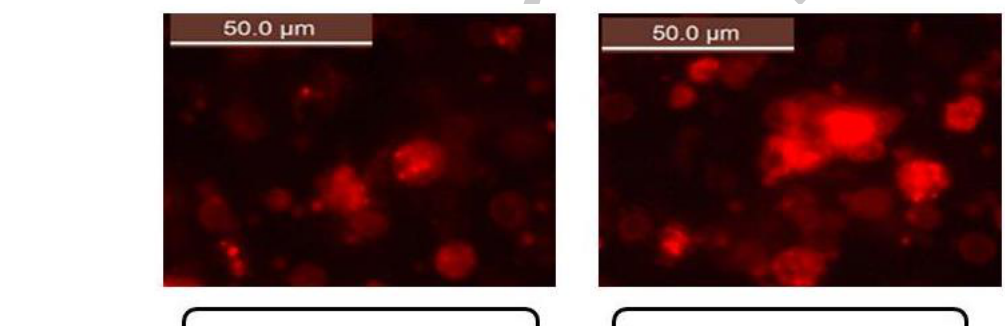
Figure 3. Stem cells labeled with PKH26 dye in pancreatic tissues of diabetic groups at the end of the experiment (50.0 µm) shown under a fluorescence microscope. MSCs labeled with PKH26 showed strong red autofluorescence after transplantation into rats, confirming that these cells were seeded in the pancreatic tissue. Upper: treatment with MSCs alone, and lower: after treatment with MSCs and vit. D. Table 1. Blood glucose level, insulin, HbA1c, and fasting serum C-peptide of control and male rats treated with stem cells, vit. D, and their combinations. betic animals with stem cells in combination with vit. D improved all the above parame- ters better than each one alone.